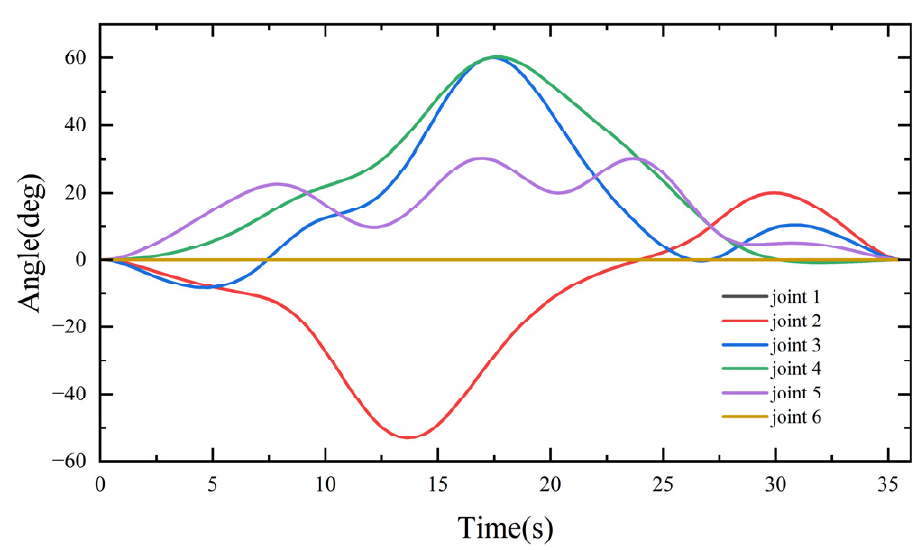
Figure 9. Six joint-angle curves.